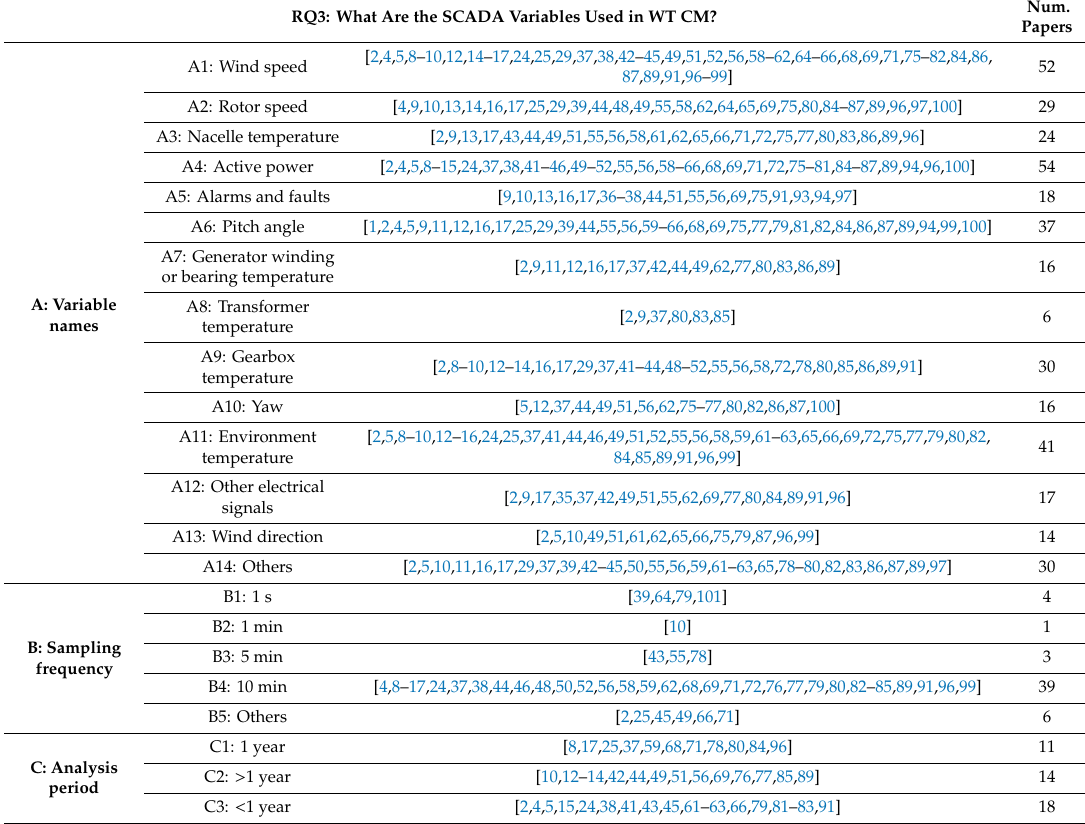
Table 7. Articles on Supervisory Control and Data Acquisition (SCADA) system variables used for the CM of WT.